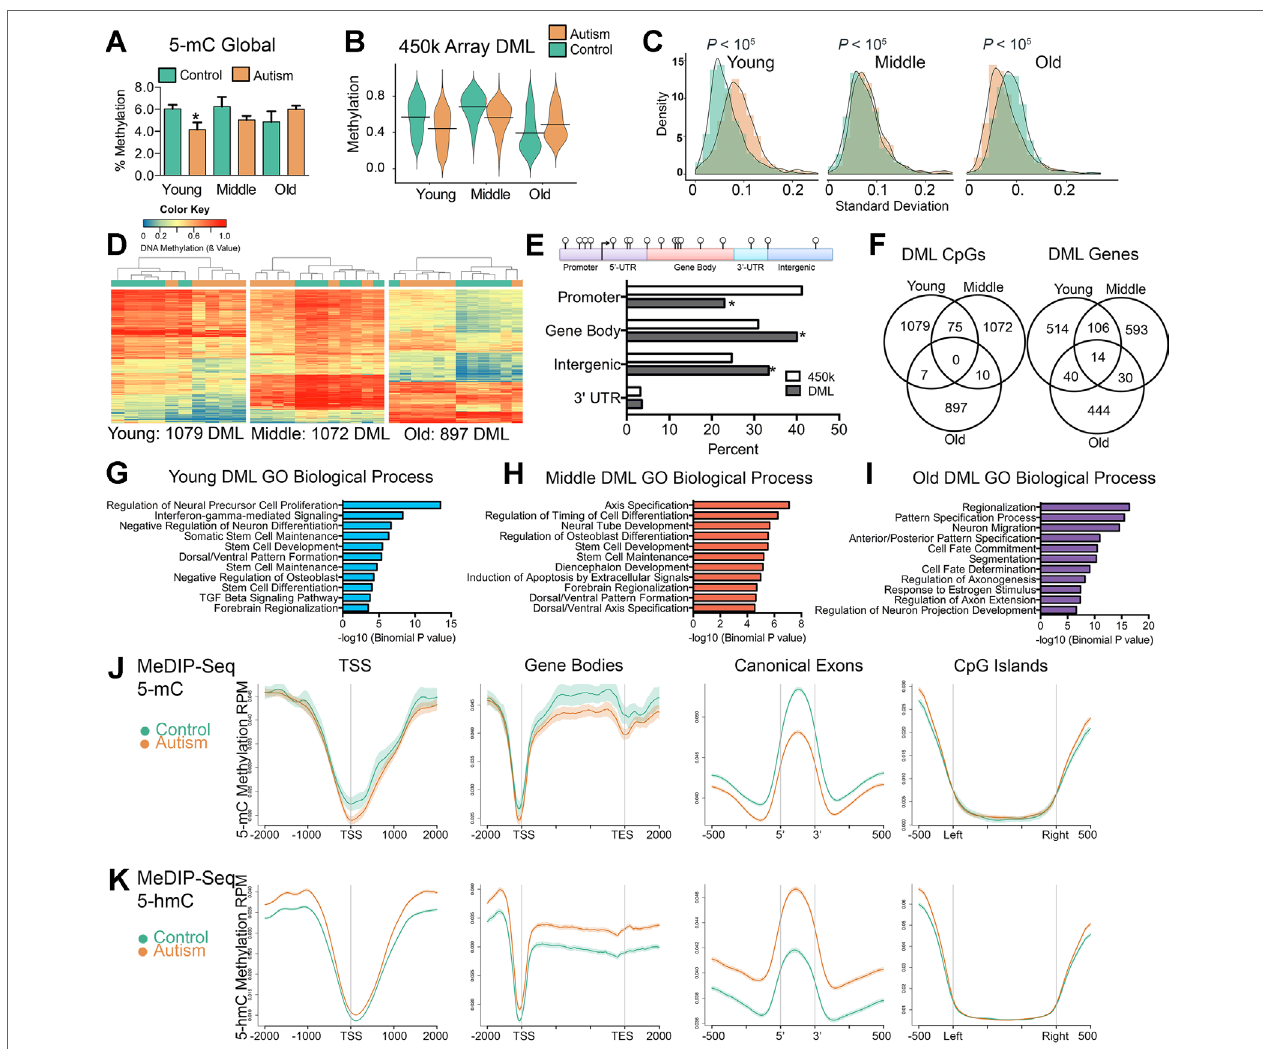
FIgURE 2 | Aberrant DNA methylation in the SVZ region of autistic brain occurs preferentially within genes involved in neurodevelopment. (A) Global levels of DNA methylation (5-mC) in control and autism cases. *indicates significant difference between young control and young autism. (B) Violin plot of differentially methylated loci between control and autism cases over three age groups. Line represents mean value of percent methylation. (C) Density plot comparing the interindividual variability (standard deviation) in levels of DNA methylation for differentially methylated loci (DML) of young, middle, and old typically developing (green) and autism- diagnosed cases (orange). (D) Unsupervised hierarchical clustering of the young, middle, and old typically developing (green color) and autism-diagnosed (orange color) cases using a heatmap based on methylation levels of DML. Dendogram shown above. Colors in the heatmap indicate CpG methylation levels (blue to red: low to high methylation levels). (E) Percent distribution of all DML in genomic regions compared to distribution of all probes based on the 450k array. * P < 0.05, χ 2 test. (F) Venn diagrams showing the overlap for differentially methylated loci (DML) and DML-related genes for typically developing compared to autism-diagnosed cases at young, middle, and old age groups. (g – I) Functional annotation of genes containing differentially methylated loci in autism by database GREAT. Enrichment in gene ontology biological process category shown for all autism-associated DML. (J) Distribution of 5-mC methylation and (K) 5-hmC methylation over the indicated bp window of all RefSeq annotated TSS, gene bodies, canonical exons, and CpG islands. Methylation of control (green line) and autism (orange line) are displayed as mean RPM values with SEM indicated as a semitransparent shade around the mean